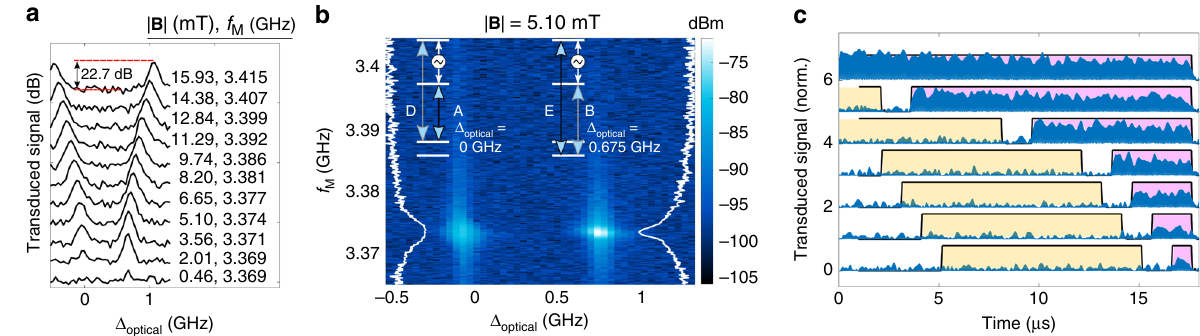
Fig. 3 Continuous wave and pulsed microwave-to-optical transduction from the waveguide device. a Transduction signal produced at the D and E optical transition frequencies as a function of the applied fi eld along the c -axis. The transduction is mediated by optically driving transitions A ( Δ optical = 0 GHz) and B ( Δ optical = 0.675 GHz) in their respective V-systems. The signal is optimized when the input microwave fi eld frequency f M is resonant with the excited state hyper fi ne transition at ~3.4 GHz. b A double resonance scan showing the transduced signal as a function of both the optical and microwave frequencies, which provides an indication of the inhomogeneous broadening of the relevant transitions. (Detection bandwidth = 3 kHz, optical pump power in the waveguide = 2 µ W, Rabi frequency Ω o ≈ 6 MHz, and microwave power of − 5.3 dBm in the coplanar waveguide, Rabi frequency Ω m ≈ 1 MHz.) White curves show the transduced signal (log scale) as a function of f M at the middle of the optical inhomogeneous line. c Pulsed transduction signals (offset for clarity) generated at f t (blue) at the maximum ef fi ciency point in b . The yellow pulse indicates excitation at f o only, whereas during the purple pulses the ensemble is excited with both f o and f M generating the transduced fi eld.